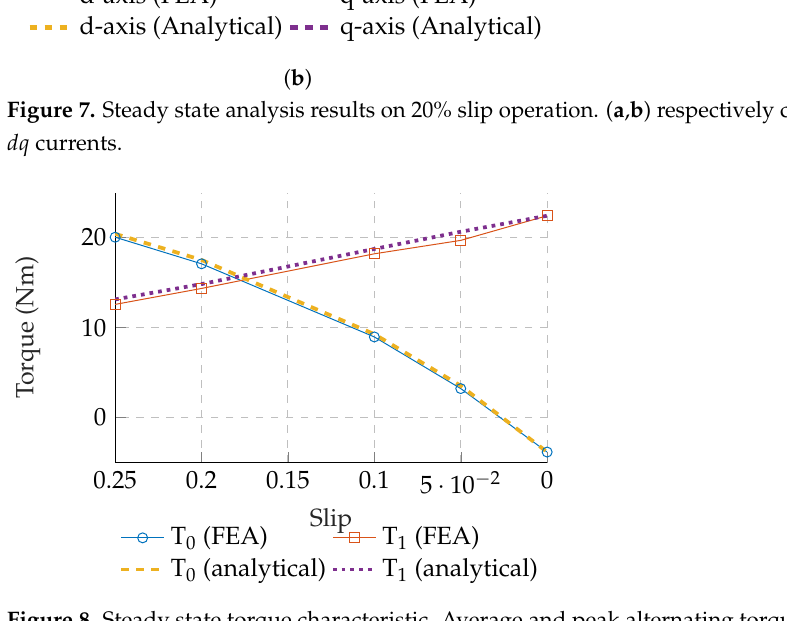
Figure 8. Steady state torque characteristic. Average and peak alternating torque are portrayed. Synchronization analysis was carried out with the obtained steady state torque as a function slip. The load is assumed to have a quadratic relationship with the rotor velocity. The results of FEA are compared in Figure 9 with those of the FE-aided analytical approach described in (14). The critical inertia given by the FEA was used to estimate that the synchronization process would fail if the inertia increased 5% more than the given